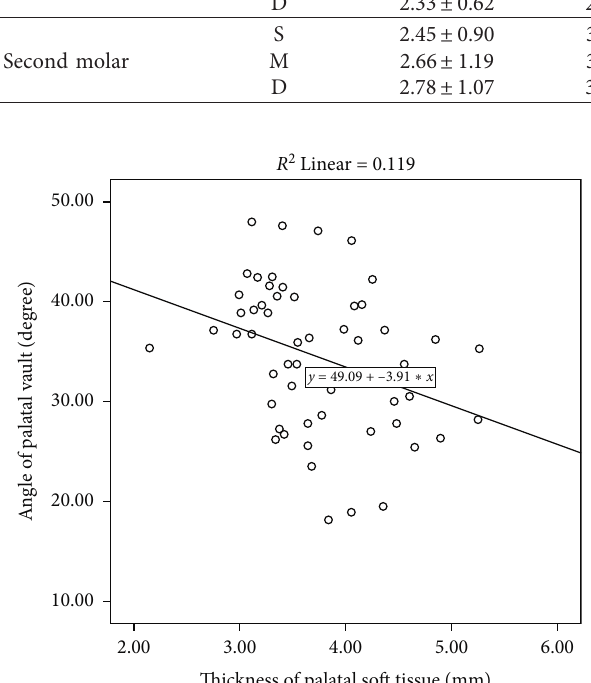
Figure 4: Scatter plot showing the correlation between the palatal vault angle and thickness of palatal soft tissue (correlation coefficient � − 0.345, p value �